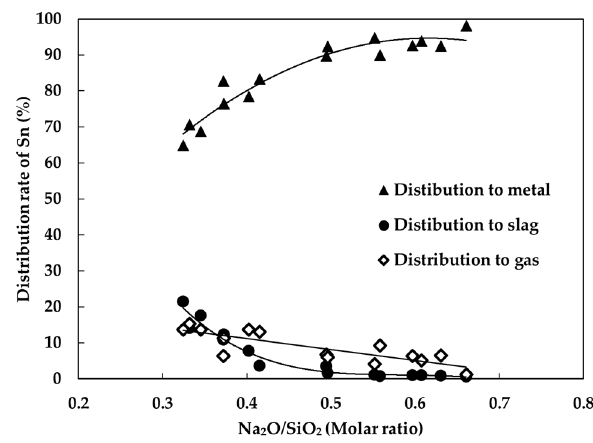
Figure 5. Effect of Na 2 O/SiO 2 molar ratio on distribution rate of tin (1200 °C, 2 h). Table 2. The amount of tin in produced metal and slag with different basicity (1200 °C, 2 h). Na 2 O/SiO 2 0.320 Na 2 O/SiO 2 Sn in Slag